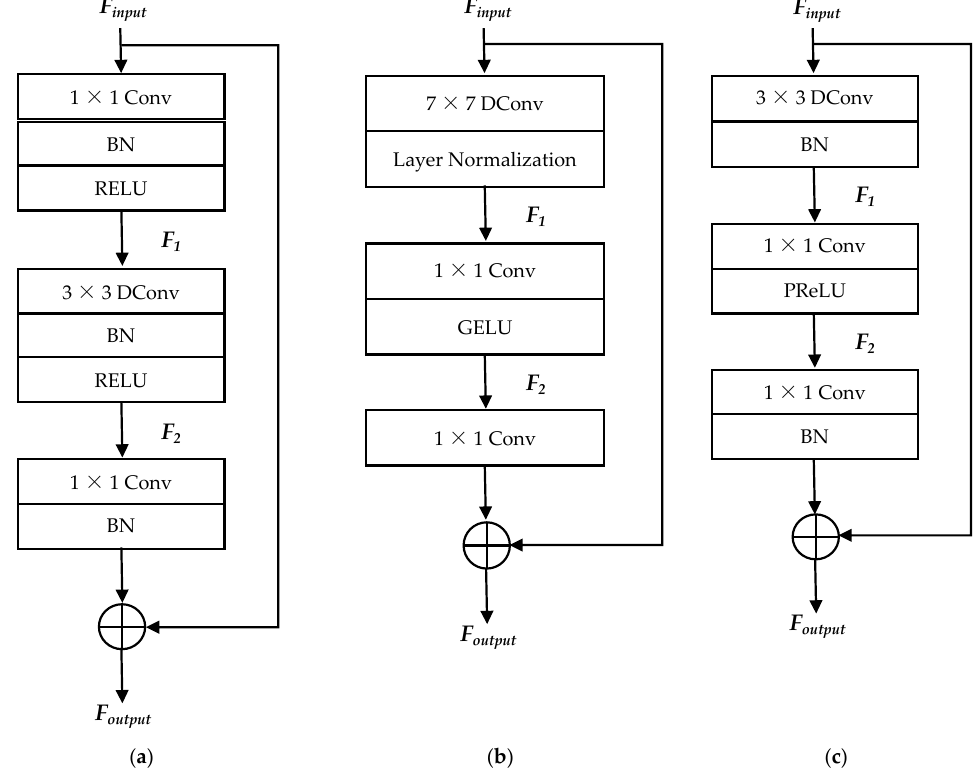
Figure 1. Different types of building blocks. ( a ) Inverted residual block. ( b ) ConvNeXt block. ( c ) The proposed Enhanced ConvNeXt (ECN) block. Here, ‘Conv’ represents convolution operation, ‘BN’ represents batch normalisation and ‘DConv’ represents depthwise